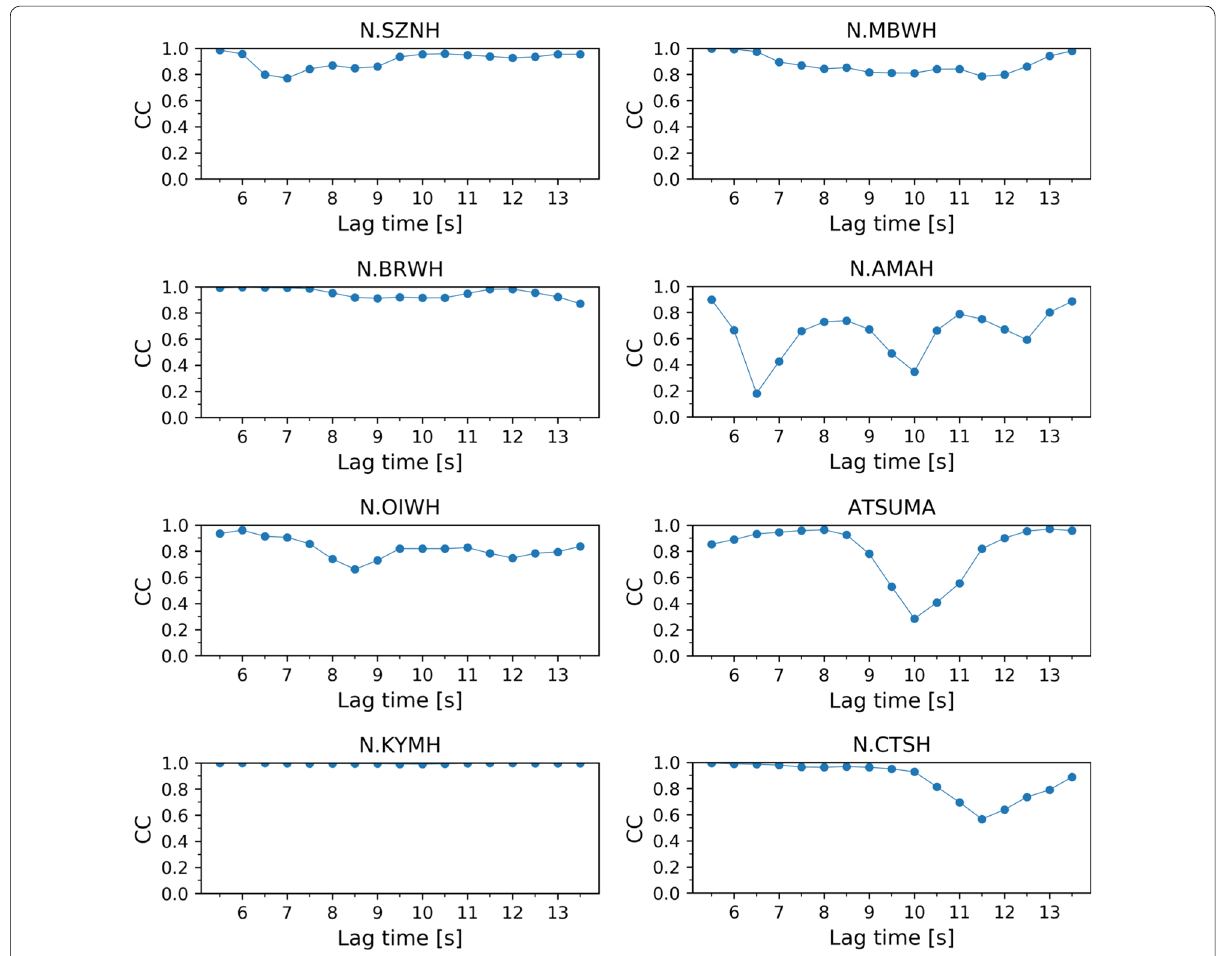
Fig. 5 The relationship between cross-correlation coefficients and lag times for each